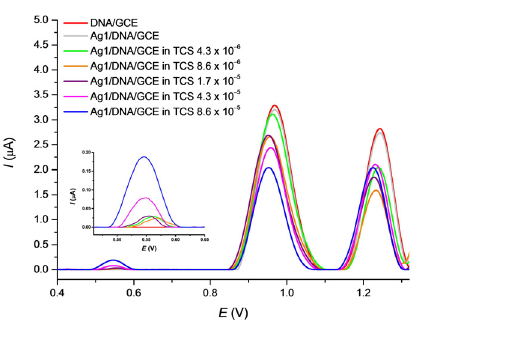
Figure 3. SWV curves recorded after 15 min. incubation of the DNA/GCE biosensor in TCS solu- tions of various concentration in 0.1 mol·L − 1 PB pH 7.4. SWV conditions: amplitude 20 mV, fre- quency 50 Hz, step potential 4 mV and scan rate 200 mV·s − 1 .